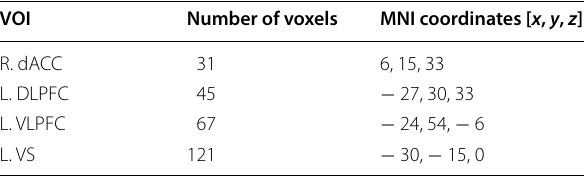
dACC dorsal portion of anterior cingulate cortex, DLPFC dorsolateral prefrontal cortex, VLPFC ventrolateral prefrontal cortex, VS ventral striatum, L left, R